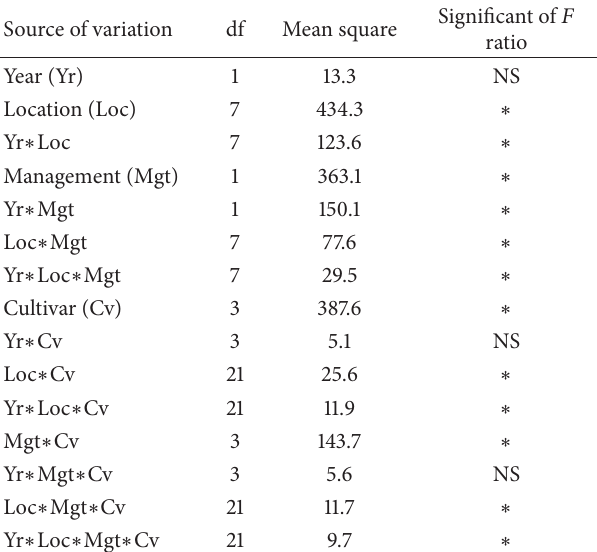
Table 3: Statistical significance of fixed and random effects on biomass yield for four switchgrasscultivars and two cutting manage- ments across eight locations in 2001 and 2002 in the upper southeast